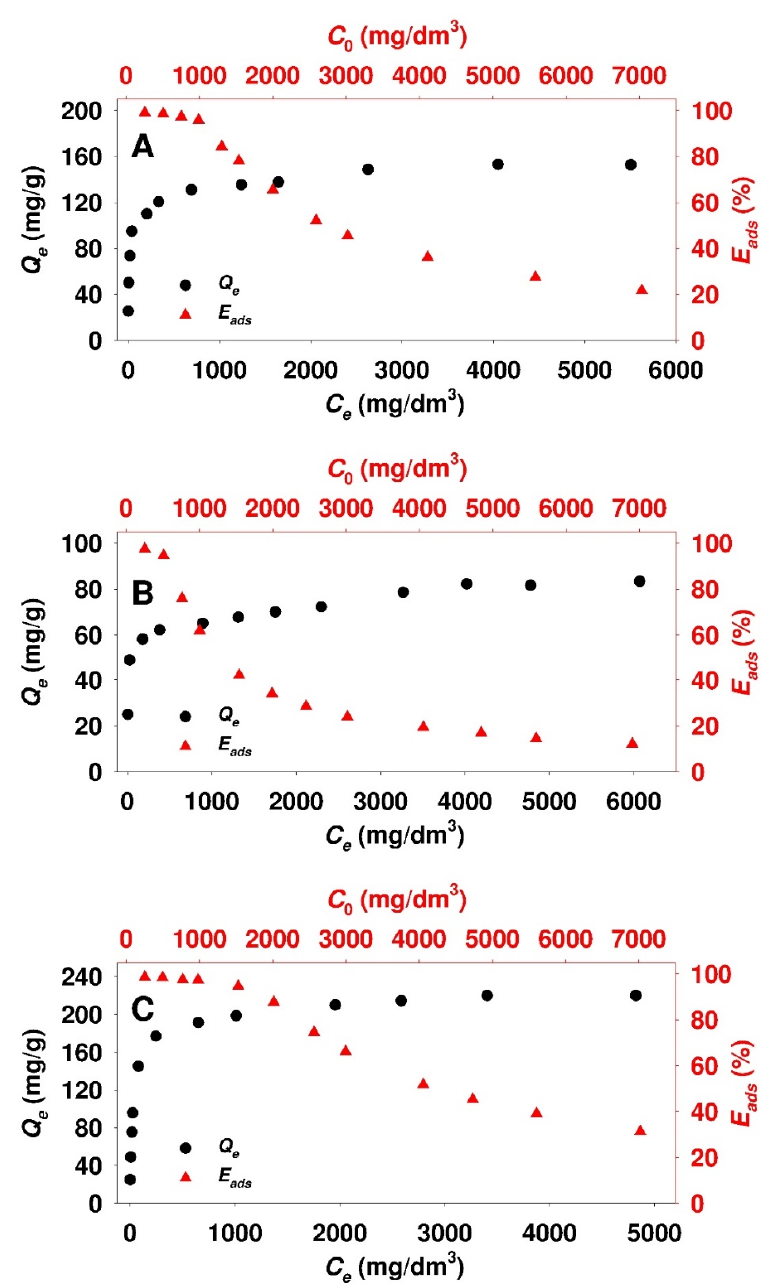
Figure 5. Adsorption isotherms and efficiency of ticagrelor in acetonitrile medium onto: ( A ) SBA‐15‐(CH 2 ) 3 ‐SO 3 H, ( B ) PHTS‐(CH 2 ) 3 ‐SO 3 H and ( C ) MCM‐41‐(CH 2 ) 3 ‐SO 3 H mesoporous adsorbents.